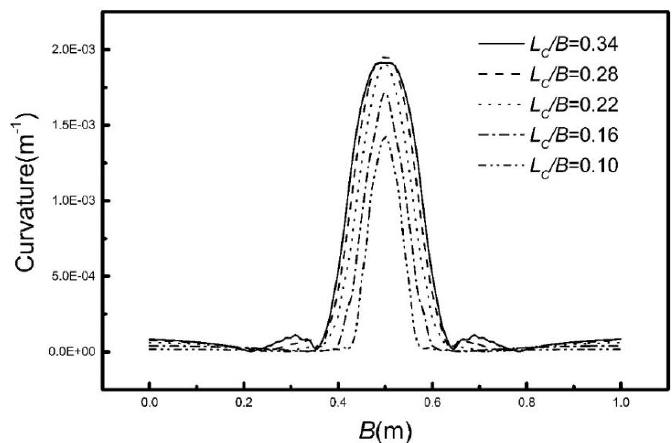
Figure 14. Effect of coil width on transversal curvature.